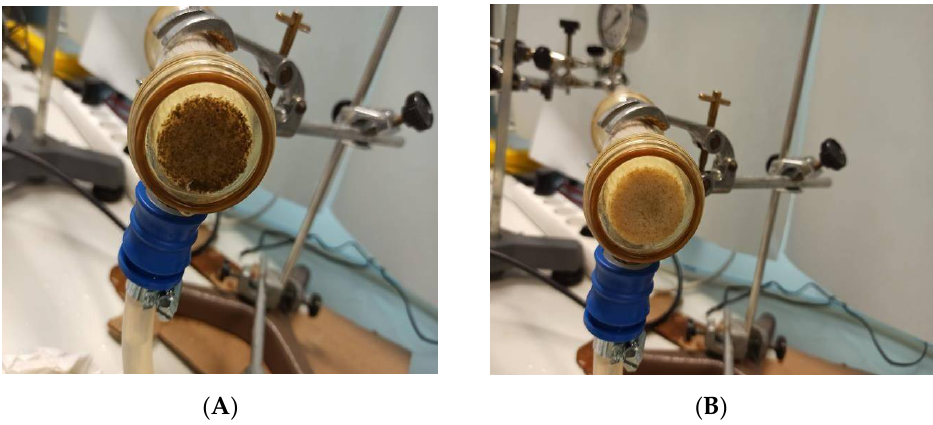
Figure 3. Scenario C. ( A ) Lumen plugging after use. ( B ) Membrane after opening and physical clean- ing.